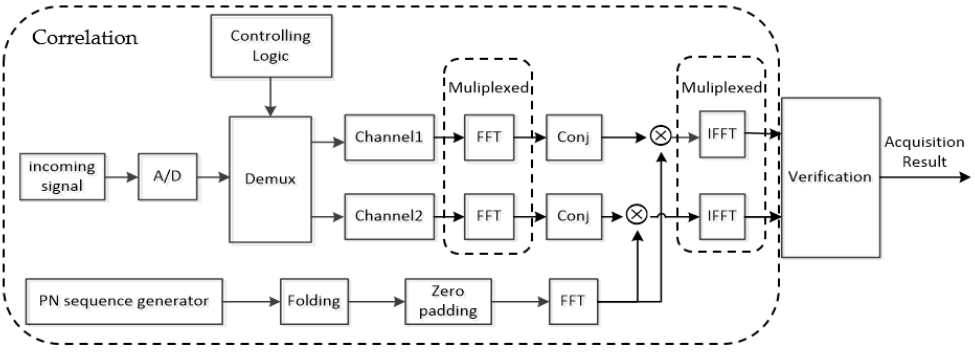
Figure 1. System model of DC-XFAST.